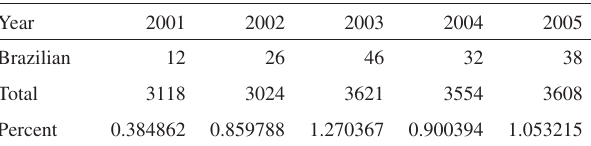
Figure 2 - Time to publication of Brazilian studies accepted for oral presenta- tions, oral discussions and poster presentations, in comparison with abstracts in the “publication only” category (tick marks represent censoring)